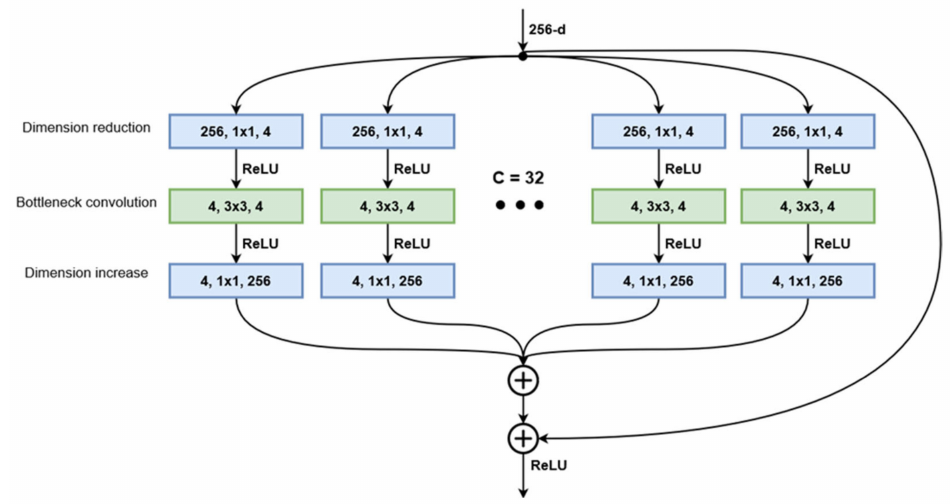
Figure 2. Structure of the split-transform aggregate block with cardinality 32 and bottleneck width